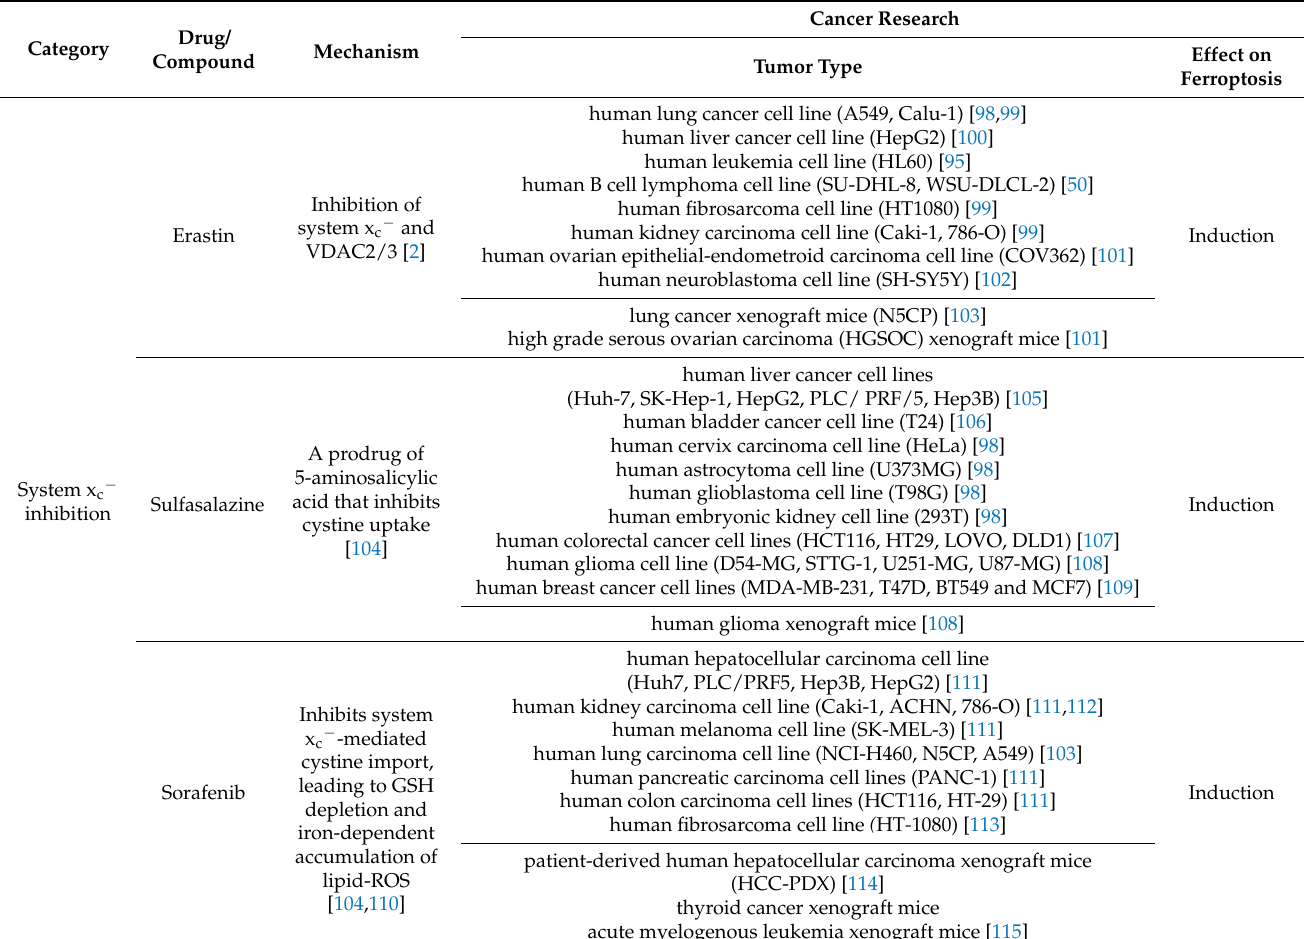
Table 1. Selected drugs and compounds associated with targeting the ferroptotic pathway. This table lists compounds currently known to induce or promote ferroptosis, including their classification, mechanism, suitability for in vivo administration, and in which type of cancer they have already been